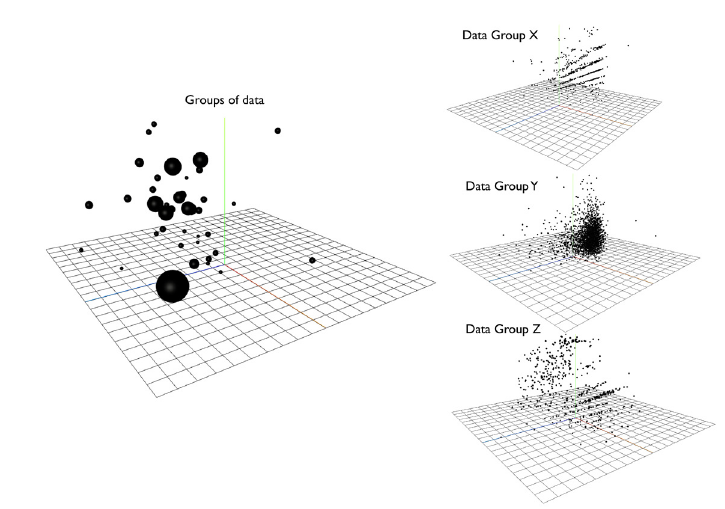
Figure 2. Aggregated data objects exploration with